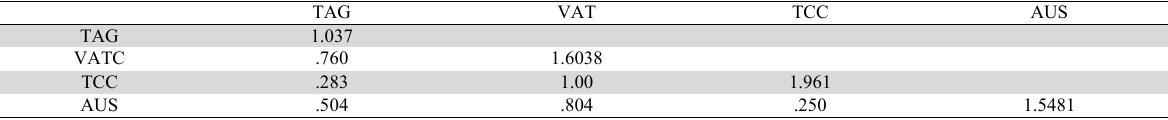
TAG VAT TCC AUS